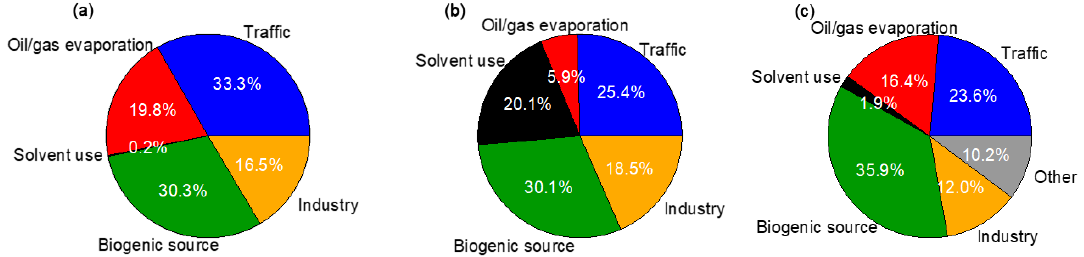
Figure 12. Relative contributions of the PMF-resolved sources to ( a ) LCR of benzene, ( b ) LCR of 1,2-dichloroethane, and ( c ) NCR of acrolein.